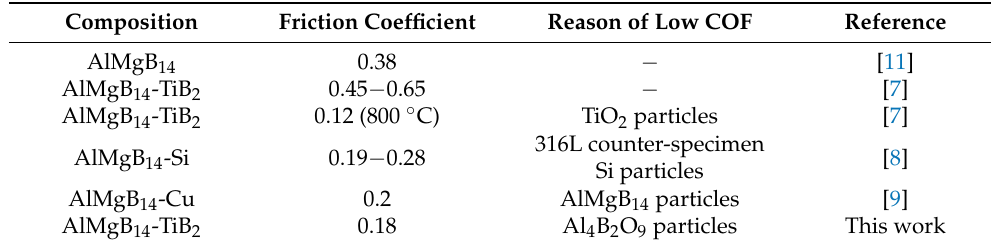
Table 6. Comparison of friction coefficients in dry conditions of the AlMgB 14 -based materials.